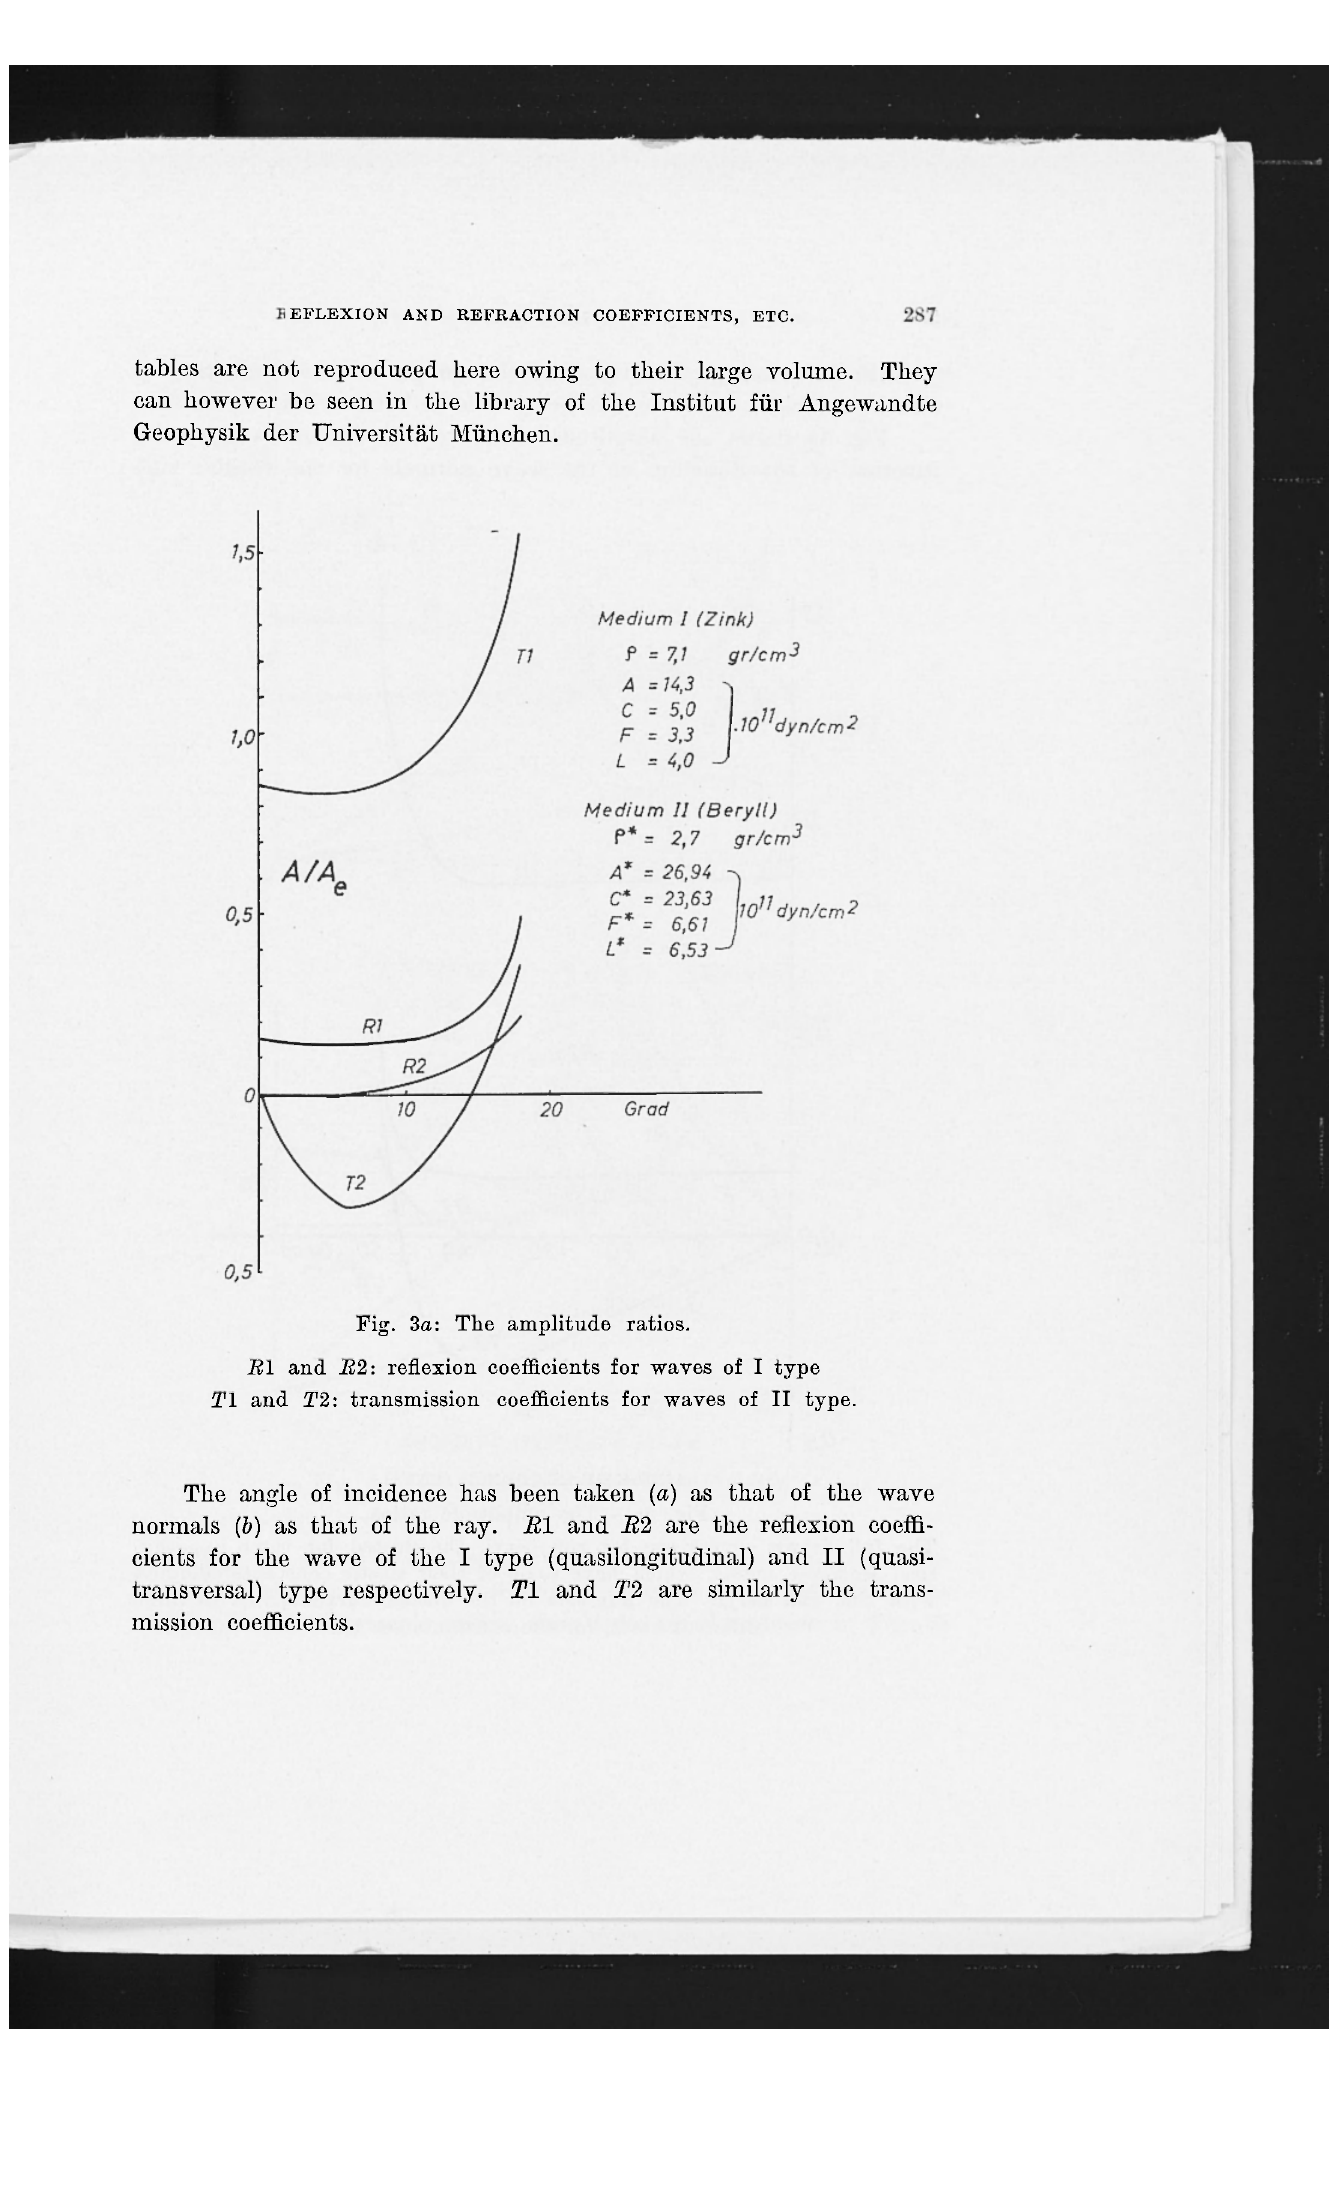
Fig. 3a: The amplitude ratios. iil and B2: reflexion coefficients for waves of I type T1 and T2: transmission coefficients for waves of II